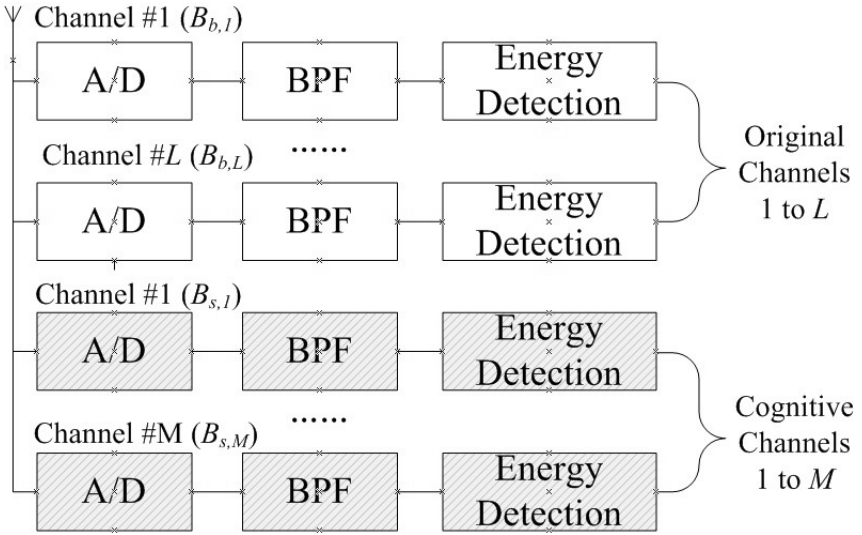
Figure 2. Block diagram of the multiband SG user’s receiver.